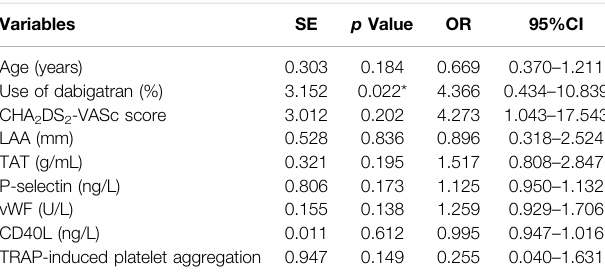
OR indicates odds ratio; 95%CI indicates 95% con fi dence interval. Multivariate logistic regression included TAT, P-selectin, vWF, and CD40L as covariates along with age, anticoagulation regimen, LAA size, and TRAP-induced platelet aggregation. CHA 2 DS 2 - VASc score was also included as a covariate. * represented with P < 0.05.